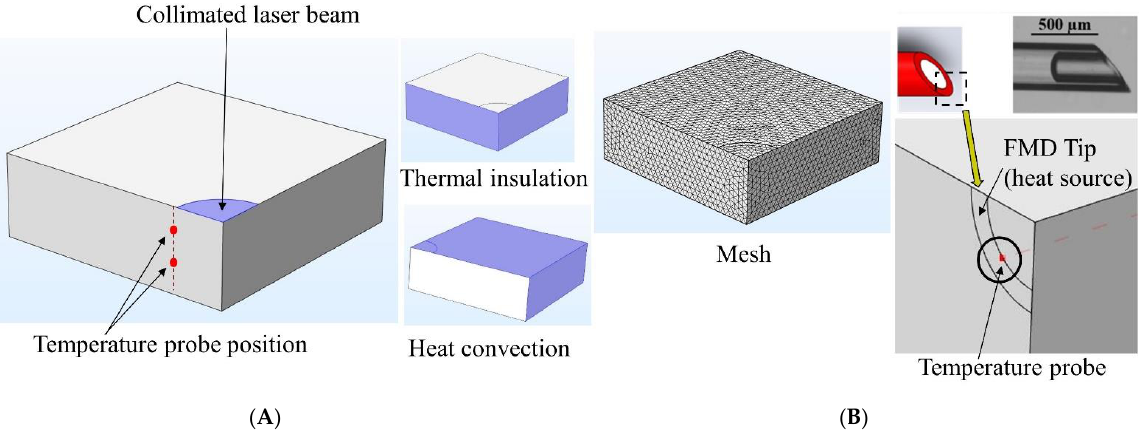
Figure 4. Computational modelling of ex vivo tissue photothermal heating by ( A ) collimated beam and ( B ) FMD. From left to right: probe positioning for the collimated beam model, boundary conditions imposed on the model, computational mesh used for FEA, FMD model, and probe position.